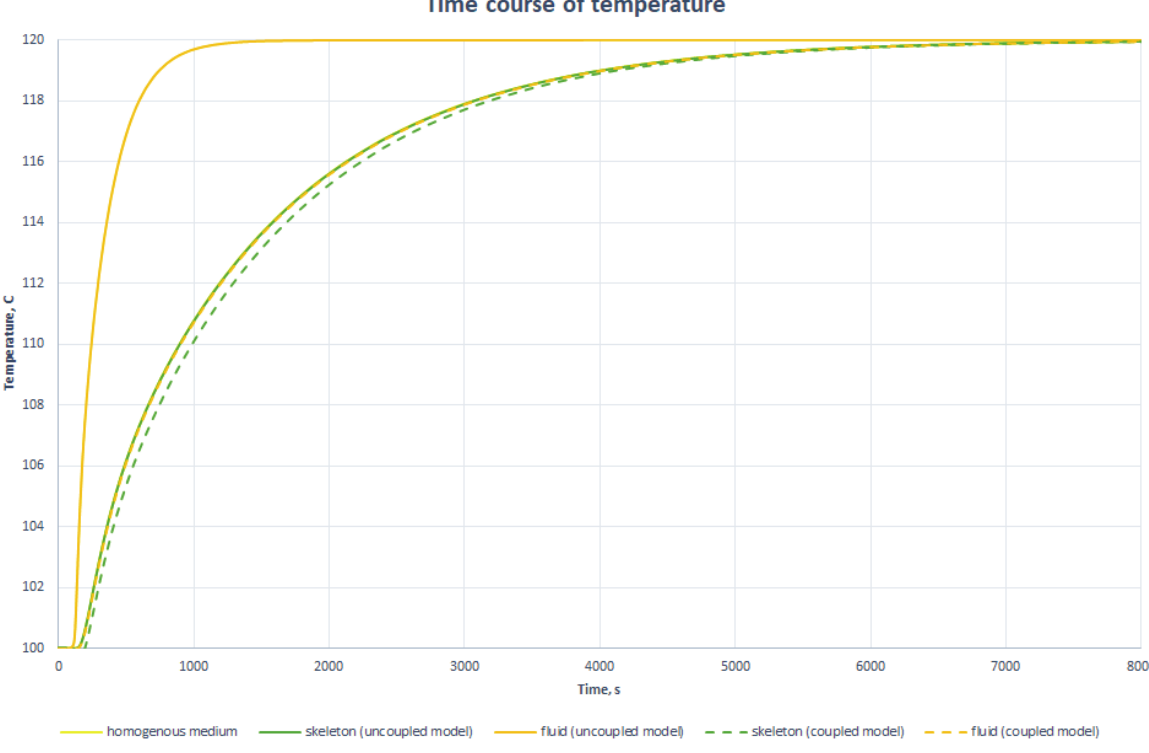
Fig. 3. Time course of temperature at the geometric center of the sample